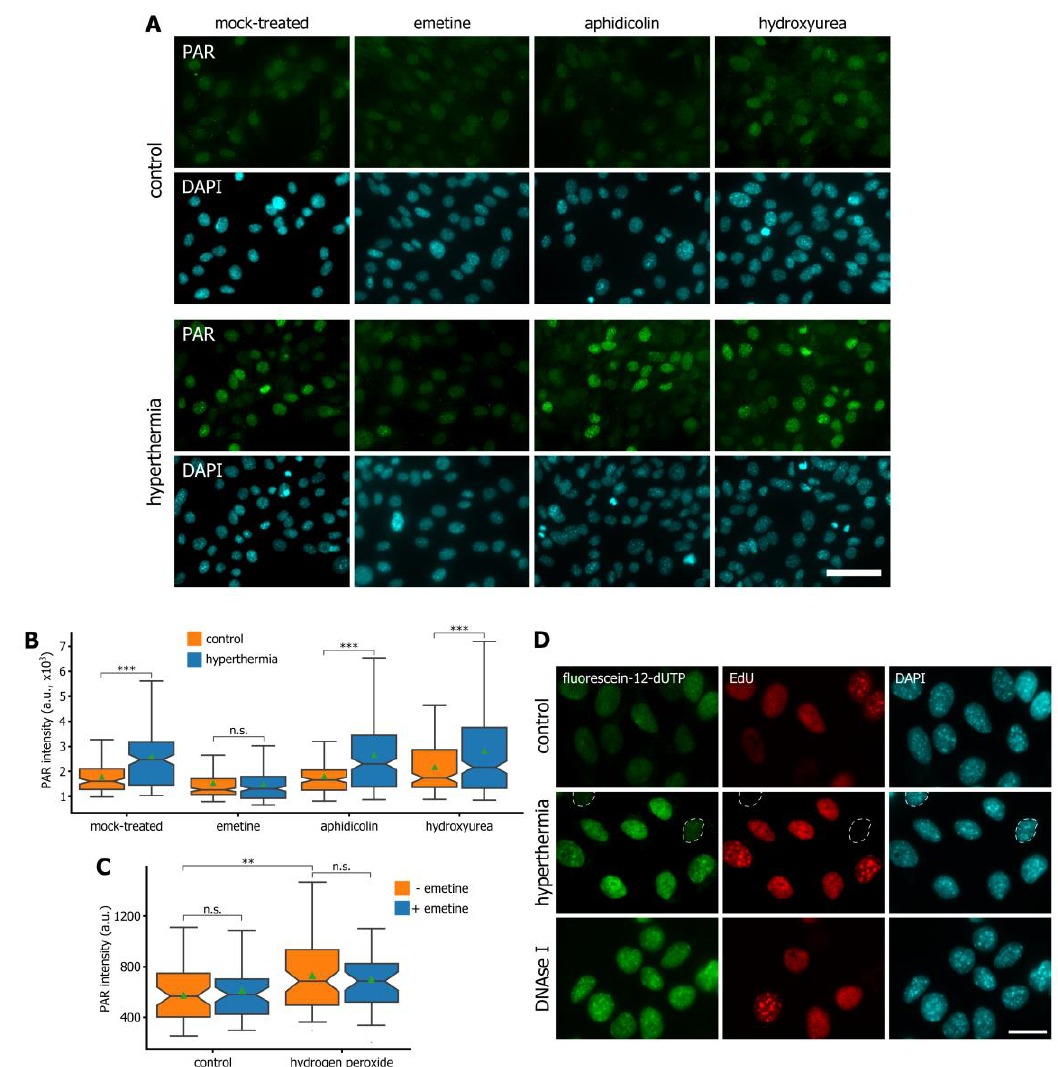
Figure 4. Suppression of Okazaki fragment formation with emetine prevents hyperthermia-induced PARylation. ( A ) HEK293 cells were mock-treated or treated with either emetine (2 mM, 1 h), aphidicolin (10 µM, 1 h), or hydroxyurea (10 mM, 1 h) and then exposed or not exposed to hyperthermia (45 °C, 30 min). The cells were immunostained for PAR. The DNA was stained with DAPI. Scale bar: 50 µm. ( B ) Quantification of PAR in HEK293 cells treated as in ( A ). Box plots show the PAR fluorescence intensities. The horizontal lines represent the median values; the triangles represent the average values. *** p < 0.0001, n.s. — not significant (two-tailed t -test, n > 100). ( C ) HEK293 cells were mock-treated or treated with emetine (2 mM, 1 h) and then treated or not with hydrogen peroxide (200 µM, 1 h). The cells were stained with antibodies against PAR. Box plots show the PAR fluorescence intensities. The horizontal lines represent the median values; the triangles represent the average values. ** p < 0.001, n.s. — not significant (two-tailed t -test, n > 50). ( D ) HEK293 cells were pulse-labeled with EdU (10 µM, 30 min), exposed to hyperthermia (45 °C, 30 min), fixed, permeabilized, and subjected to a fluorescein-labeled nucleotide analog incorporation assay using Escherichia coli DNA polymerase I. Control represents the cells that were not exposed to hyperthermia. Nuclei of the EdU-negative cells were marked by dashed circles on the middle panel to show that the hyperthermia induced SSBs only in S-phase cells. HEK293 cells that were fixed and then treated with DNase I (1 U/mL, 30 min) were used as an additional, positive, control. EdU was revealed by Click Chemistry; the DNA was stained with DAPI. Scale bar: 20 µm.